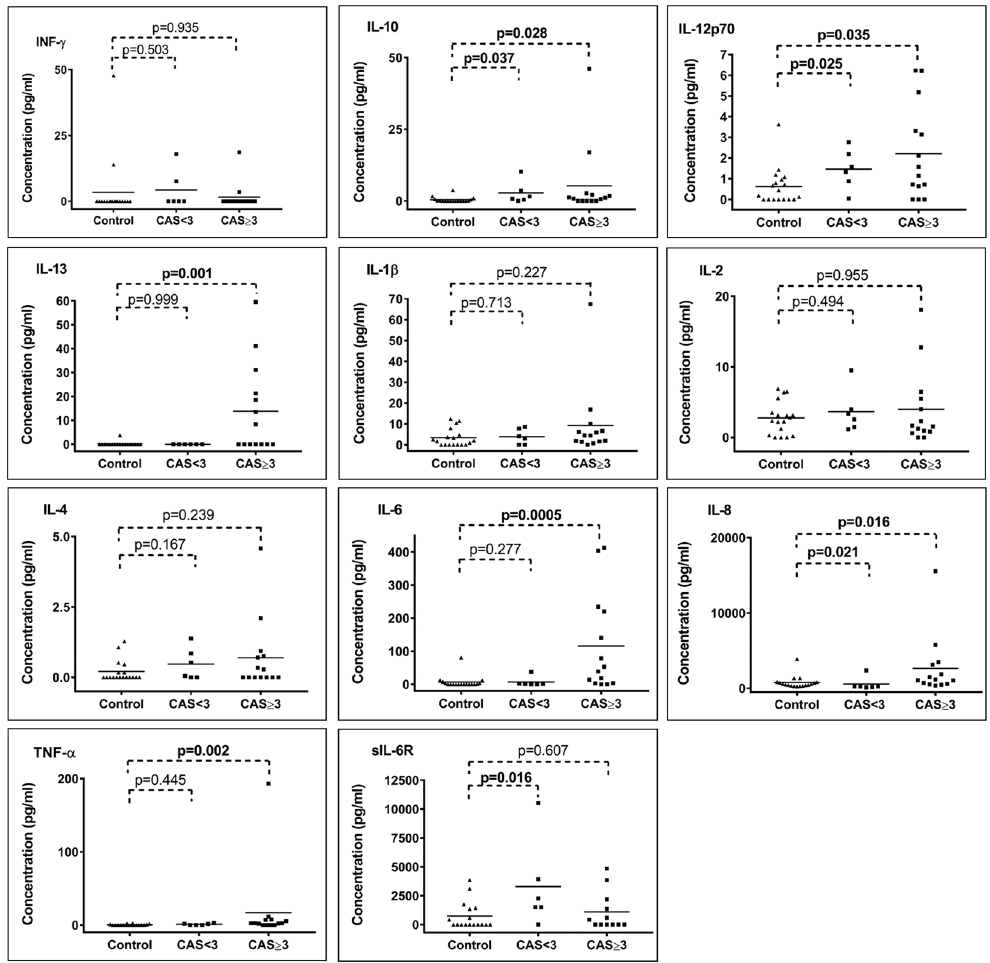
Figure 2. Cytokine concentrations (pg/ml) in tears of control subjects, patients showing a CAS < 3 and patients showing a CAS ≥ 3. * Mann-Whitney U tests, p-values (bold data highlight significant